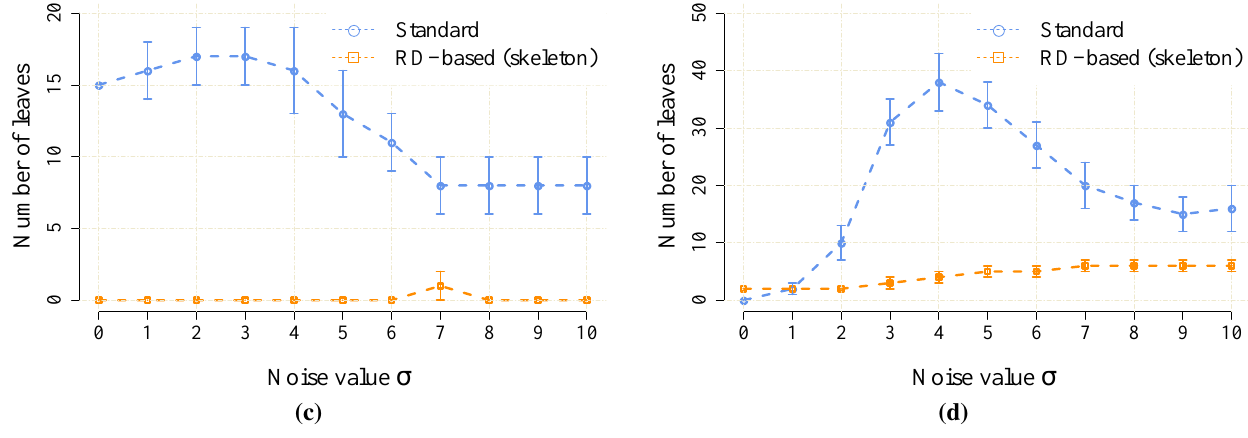
Figure 11. Average numbers of the leaves detected in the noisy maps created for the particular value of the noise level σ .